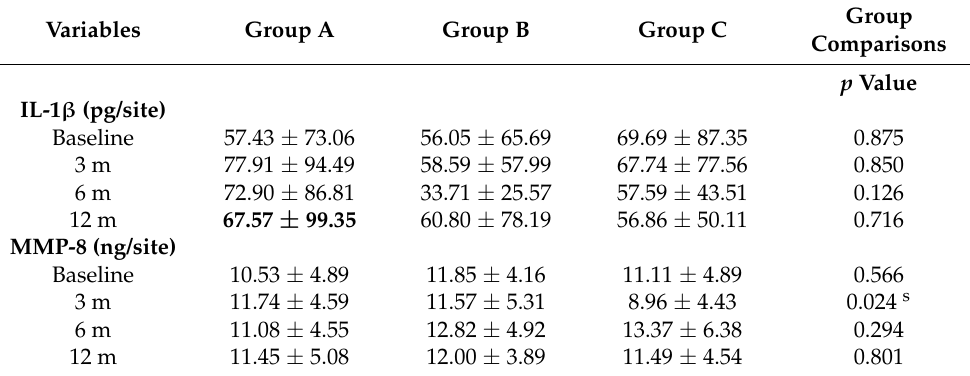
Table 4. Mean levels ( ± SD) of IL-1 β and MMP-8 in the three treatment groups (A: PDT, B: LDDs, C: control) at baseline and after 3, 6 and 12 months (mean ± SD). Variables Group A Group B Group C